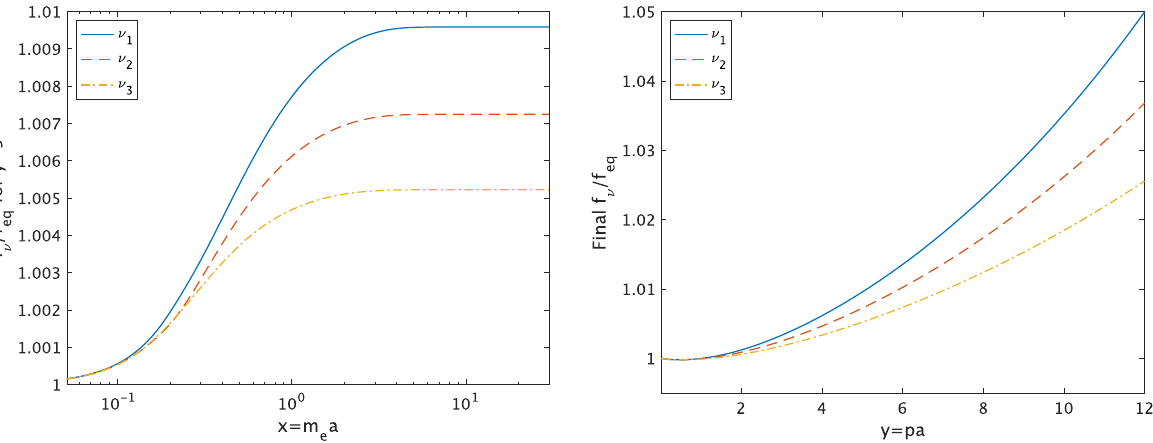
Figure 4. ( Left panel ): Time evolution of the distortions of neutrinos in the mass basis for a fixed momentum ( y = 5) with QED finite temperature corrections up to O ( e 3 ) . ( Right panel ): Final distortions of neutrino spectra in the mass basis as a function of the comoving momentum y with QED finite temperature corrections up to O ( e 3 )